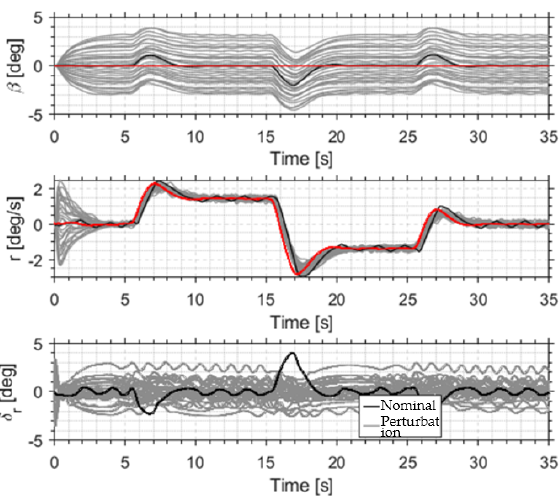
Figure 21. Perturbation simulation of the roll channel at 9 km altitude and 0.7 Mach number.